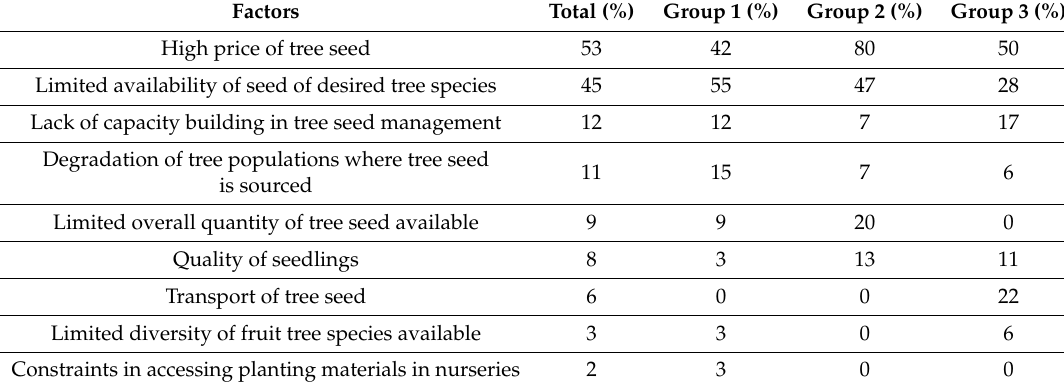
Table 7. Different issues affecting tree seed supply and frequency of citation of each issue by the different farmers directly involved in seed collection, in each of the three farmers’ groups interviewed. More than one criteria could be mentioned, so the total in each column is more than 100%. Group 1 = farmers with fences; Group 2 = farmers without fences, in the same villages as Group 1; Group 3 = farmers without fences, in different villages from Group 1 and